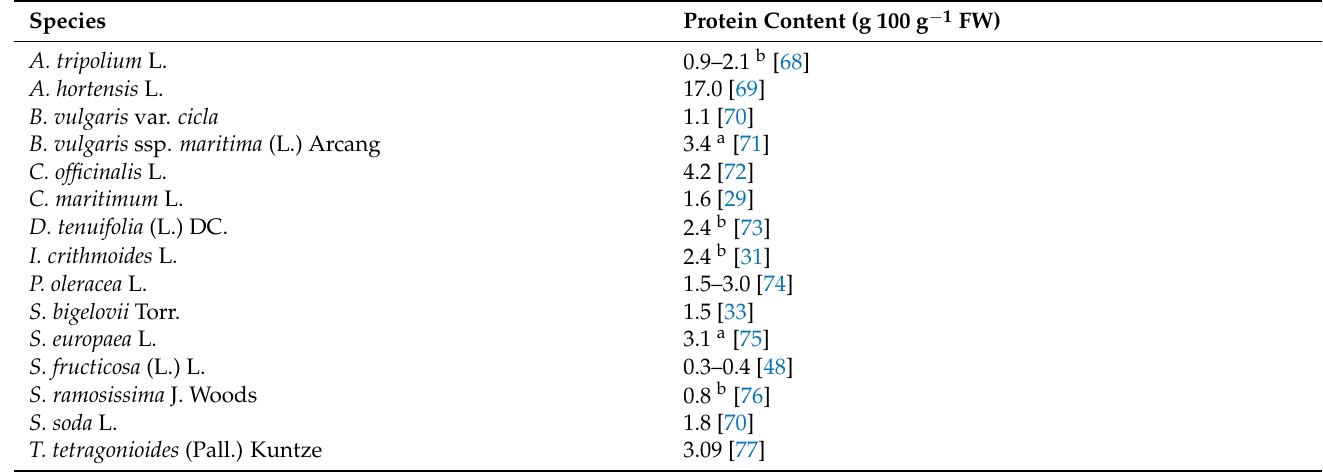
Table 6. Protein content of the considered plant species.